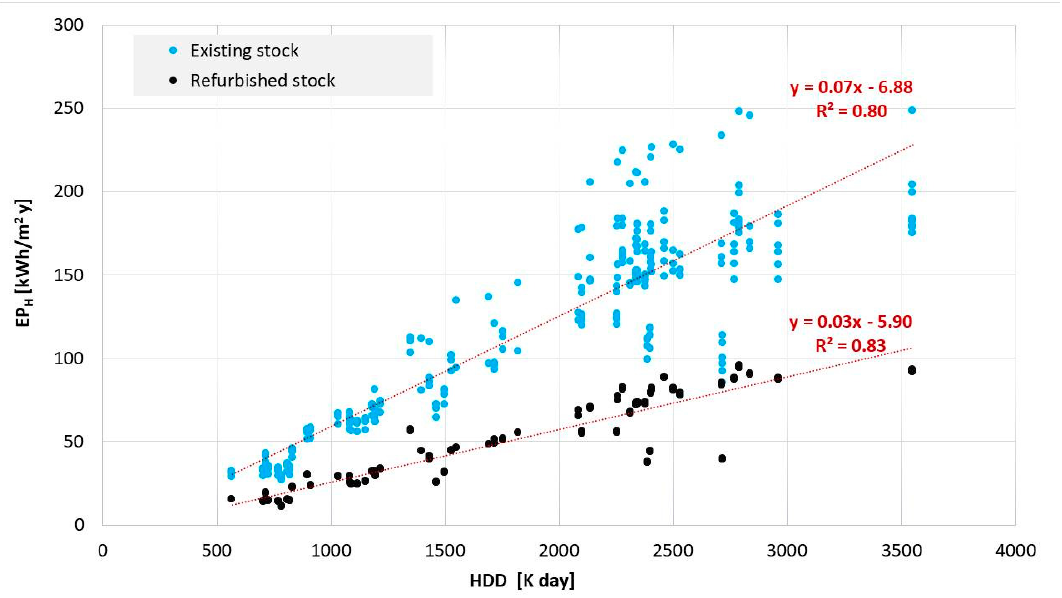
Figure 7. Primary energy for heating demand—selected weather files.